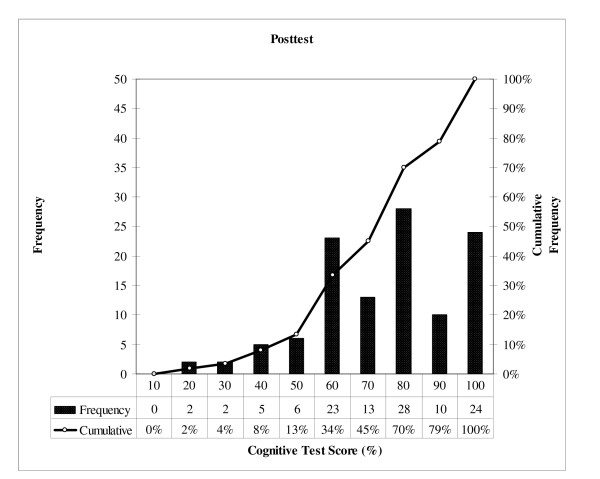
Frequency of scores for the cognitive test posttest scores.